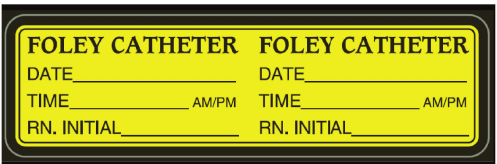
Figure 1: The indwelling urinary catheter (IUC) label design was adapted from intravenous tubing labels, familiar to our nursing staff (manufactured by United Ad Label, RR Donnelly Inc., St. Charles, IL, USA). The IUC tag ( 3 × 0.9 inches) is water resistant, self- adhesive, and brightly colored. The tags are wrapped around the tubing above the catheter drainage